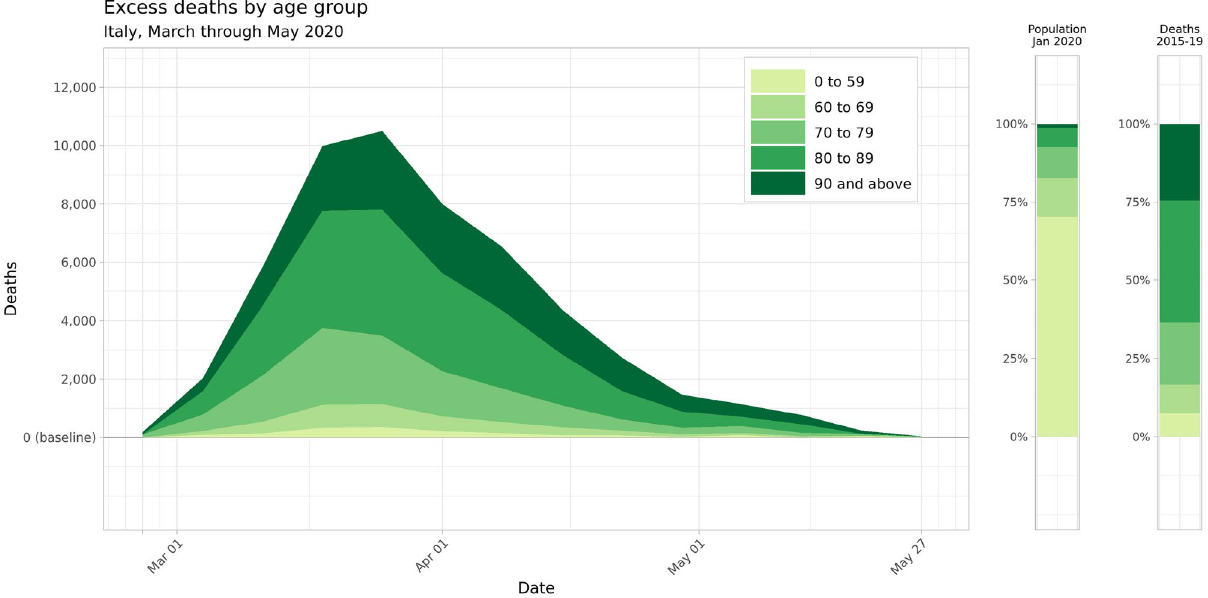
Figure 3. Mean estimates for weekly excess deaths across Italy by age group, March through May 2020. Two nationwide age group breakdowns are shown to the right for comparison: the national age distribution as of 1 January 2020, and the proportion of nationwide deaths that occurred in each age group during the years 2015 through 2019.